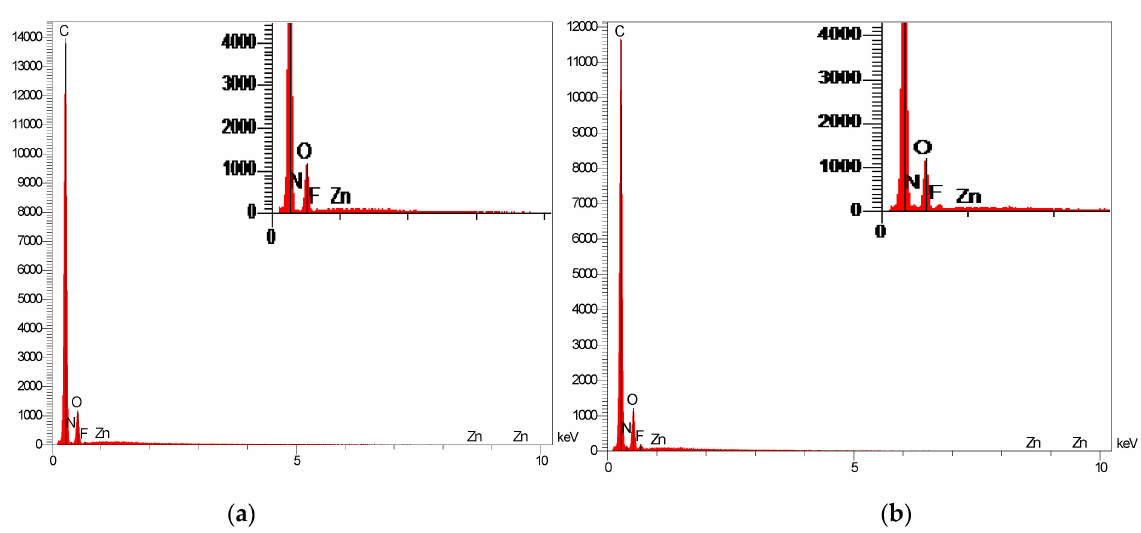
Figure 4. EDX spectra performed ( a ) on the continuous matrix phase and ( b ) on the